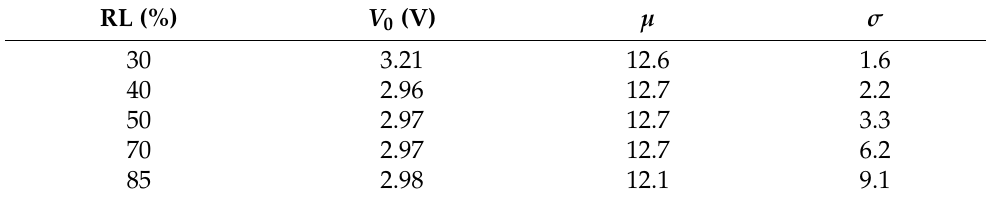
Table 7. Comparison of the output voltages, mean, and variance of the on-time for an interleaved buck converter switch 2 for different randomness levels of RCFMFD switching modulation